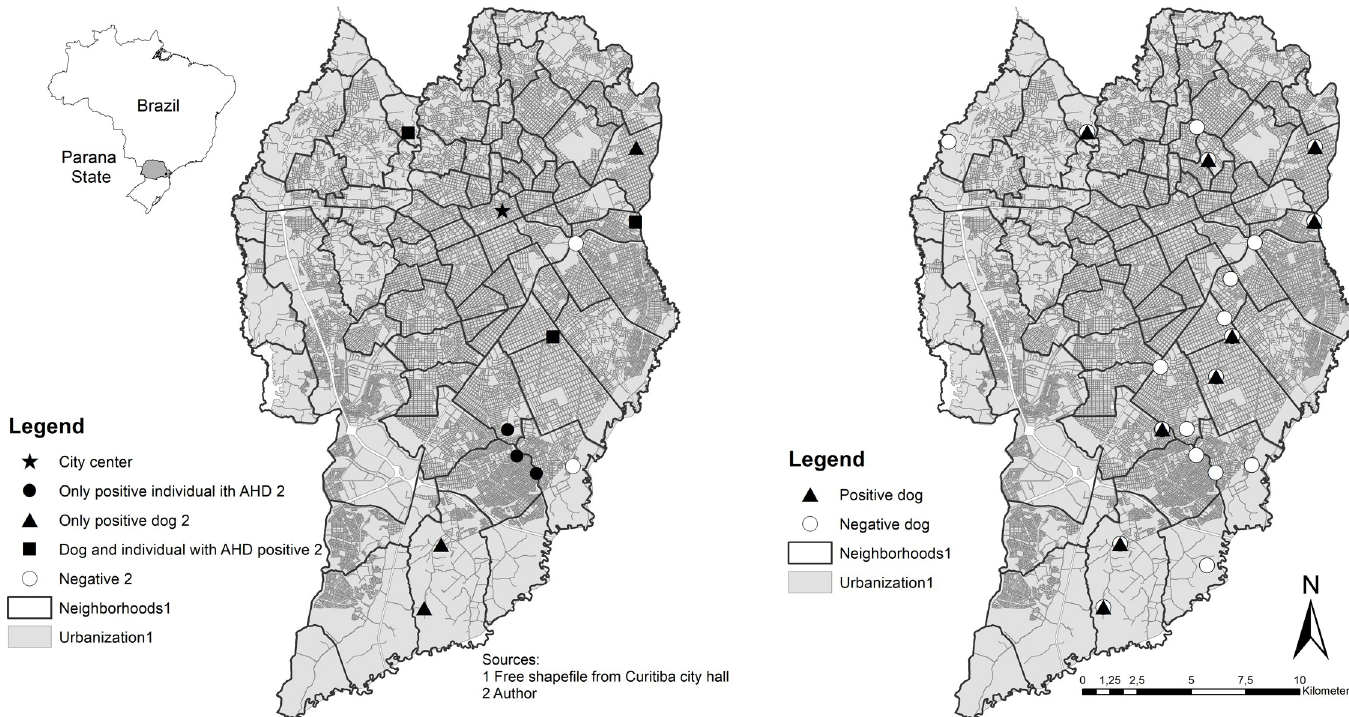
Fig 1. Spatial distribution per serological T . gondii status of 11 thoroughly assessed households (left) and 21 households where hoarded dogs were sampled (right) in Curitiba, Parana´, Brazil.